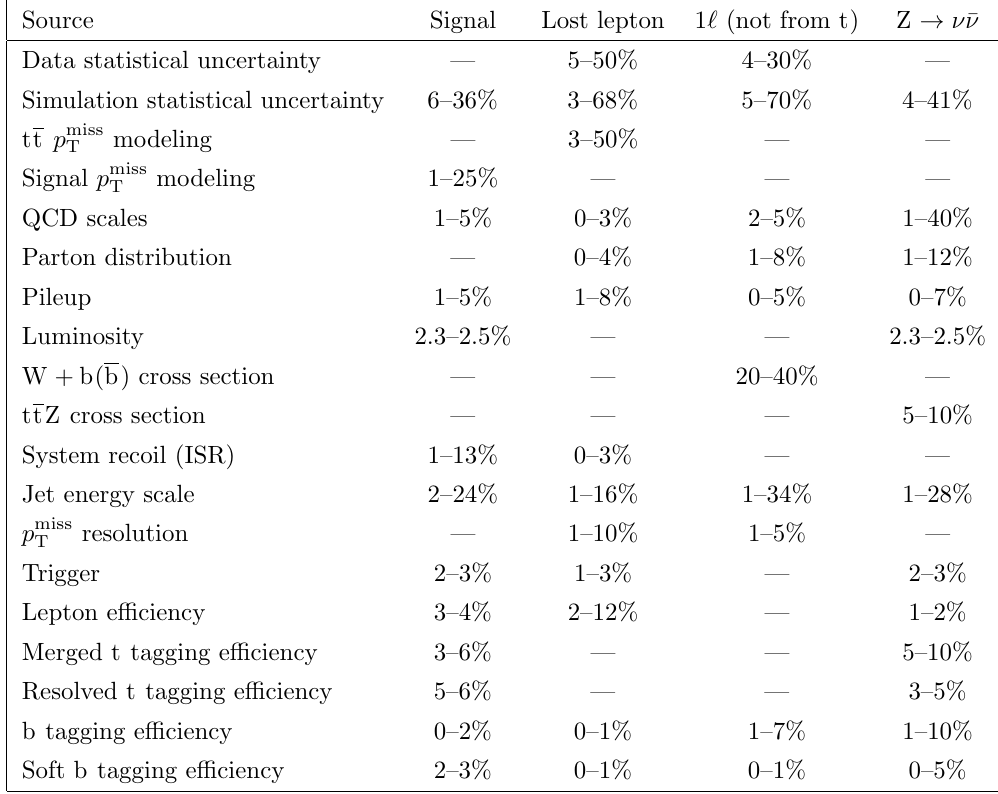
Table 6 . Summary of major systematic uncertainties. The range of values re(cid:13)ect their impact on the estimated backgrounds and signal yields in di(cid:11)erent signal regions. A 100% uncertainty is assigned to the 1 ‘ (from t) background estimated from